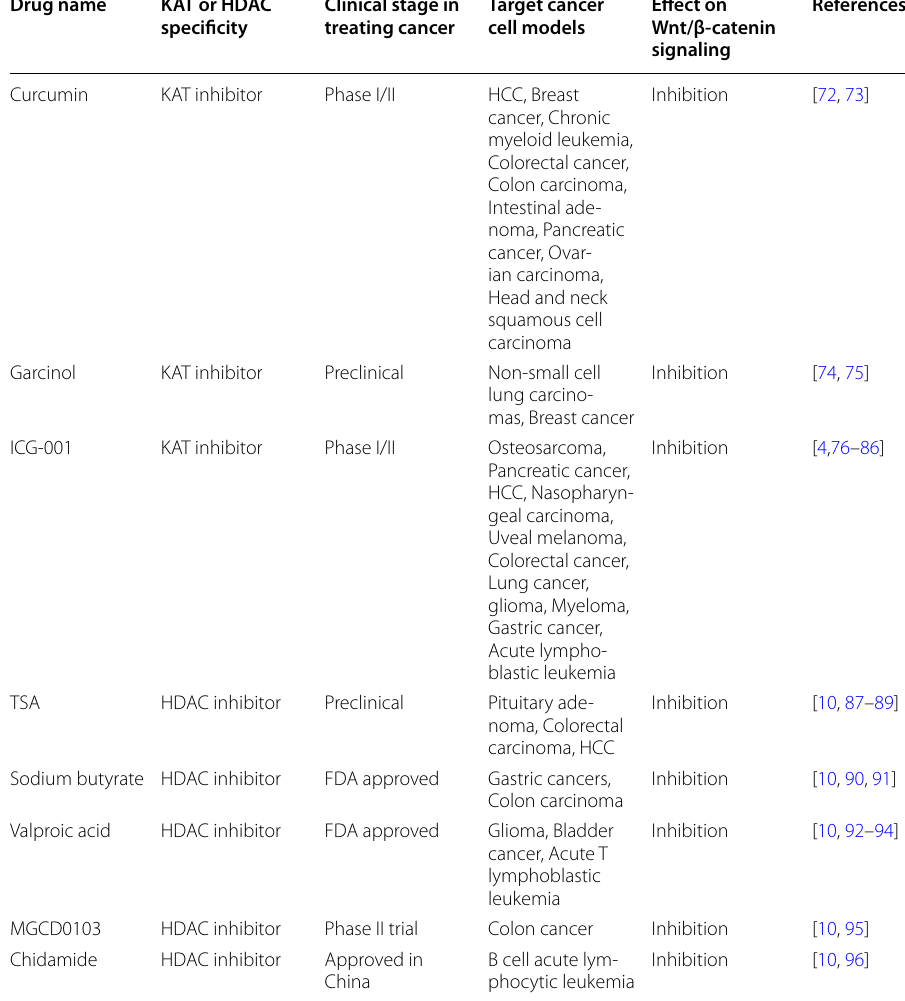
Table 2 Information on KAT inhibitors and KDAC inhibitors to suppress Wnt/β-catenin signaling Drug